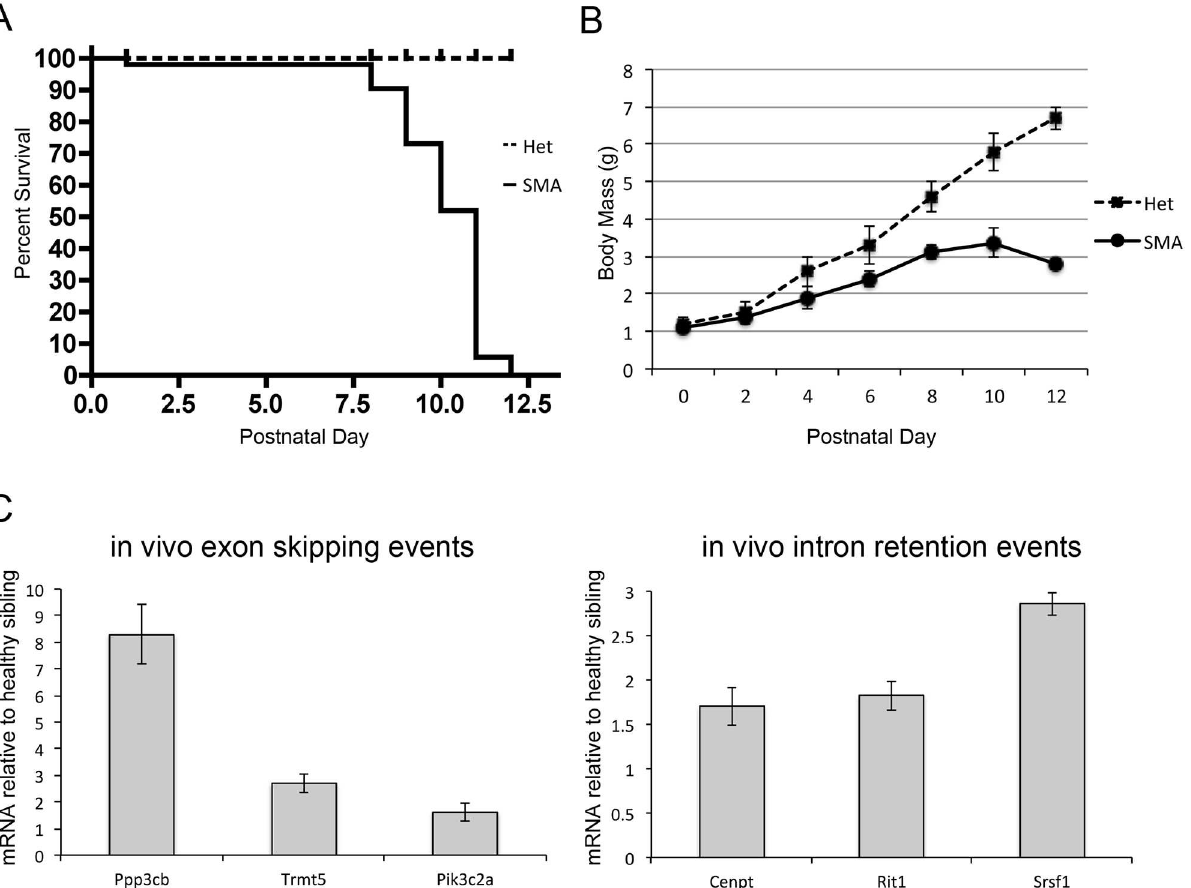
Fig 8. Alternative splicing in a mouse model of SMA. A) Kaplan-Meier analysis shows a significantlydecreasedlifespan in SMA mice compared to heterozygous (Het) littermates ( p < 0 . 01 n = 50). B) SMA mice fail to gain and maintain weight compared to the Het siblings ( p < 0.01 by two-way ANOVA). C) At postnatal day 9, SMA spinal cords show increasedlevels of exon-skipped transcripts and intron- retained transcripts comparedto Het spinal cords (p < 0.05 by Student’s